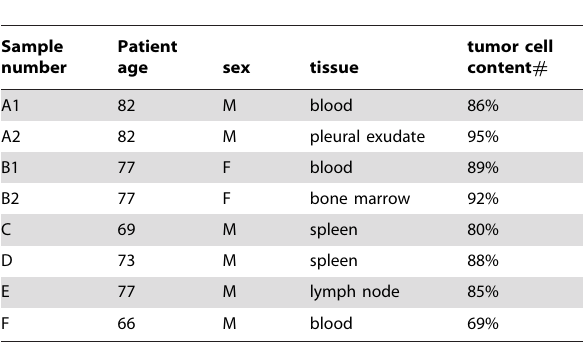
Table 4. Isolated primary MCL cells from 6 patients a) .